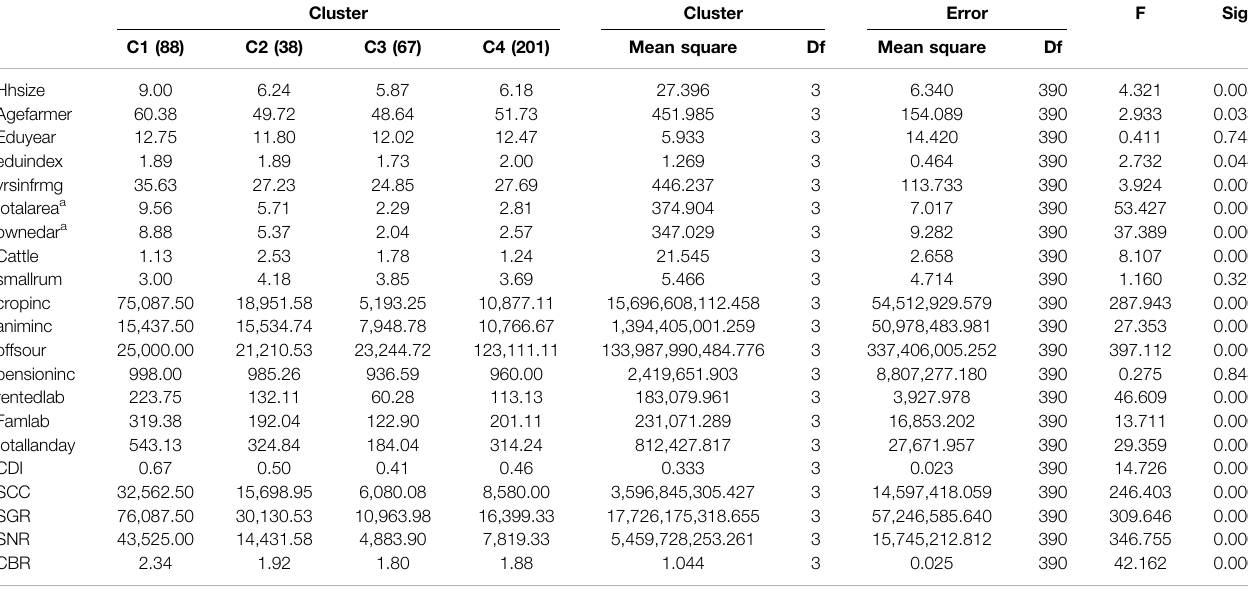
TABLE 4 | Characteristics of identi fi ed clusters of farm households and p -value of one-way analysis of variance (equality of group mean) for variables used in the characterization of farm types. Cluster Cluster Error